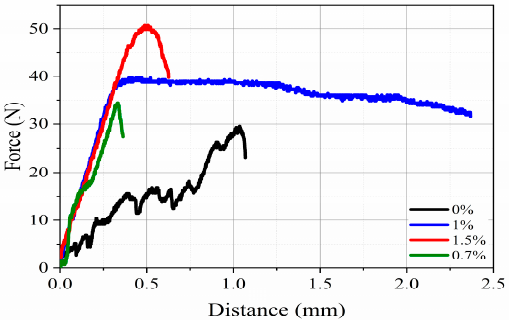
Figure 9. Curves presenting resistance force (N) versus travers of the anvil representative for the Thermacoat™ with 0%, 0.7%, 1% and 1.5% addition of polypropylene fibers.